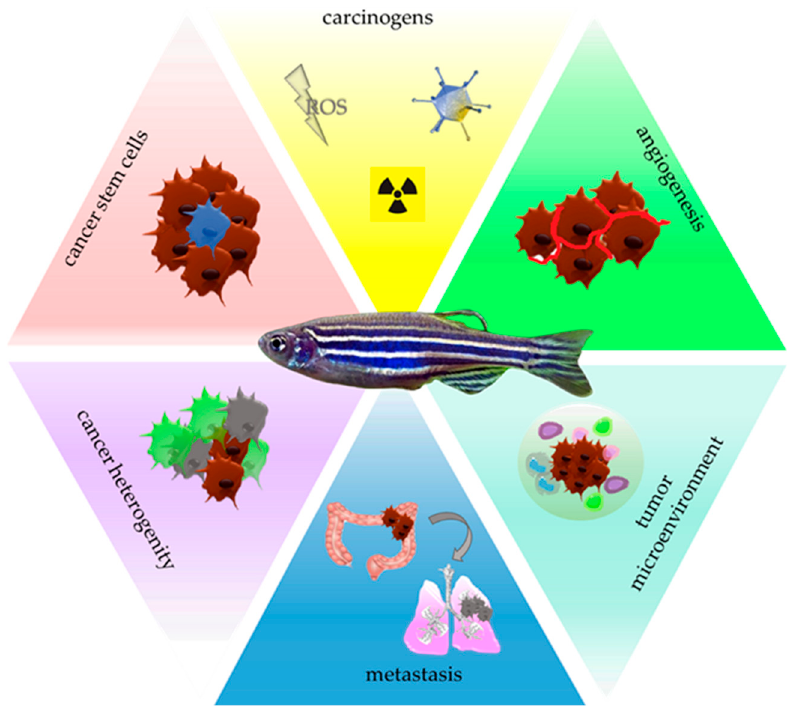
Figure 1. Zebrafish as a model to study individual stages of carcinogenesis. ROS—reactive oxygen species.